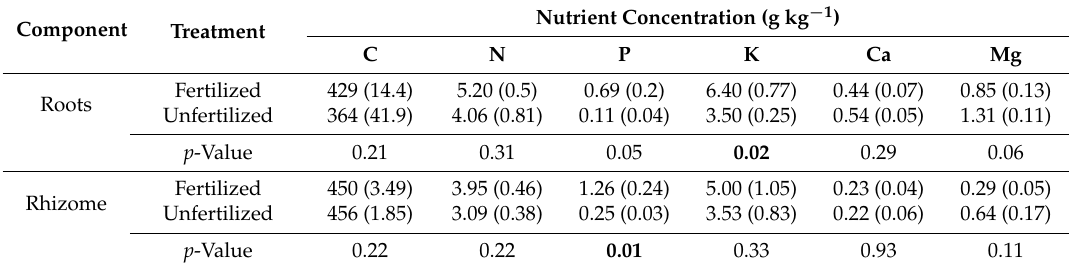
Table 3. Nutrient concentration of roots and rhizome in a Moso bamboo stand ( n =